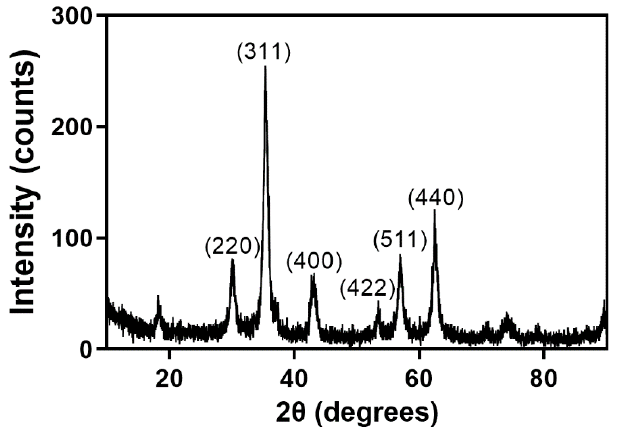
Figure 1. XRD patterns of Fe 3 O 4 nanoparticles.